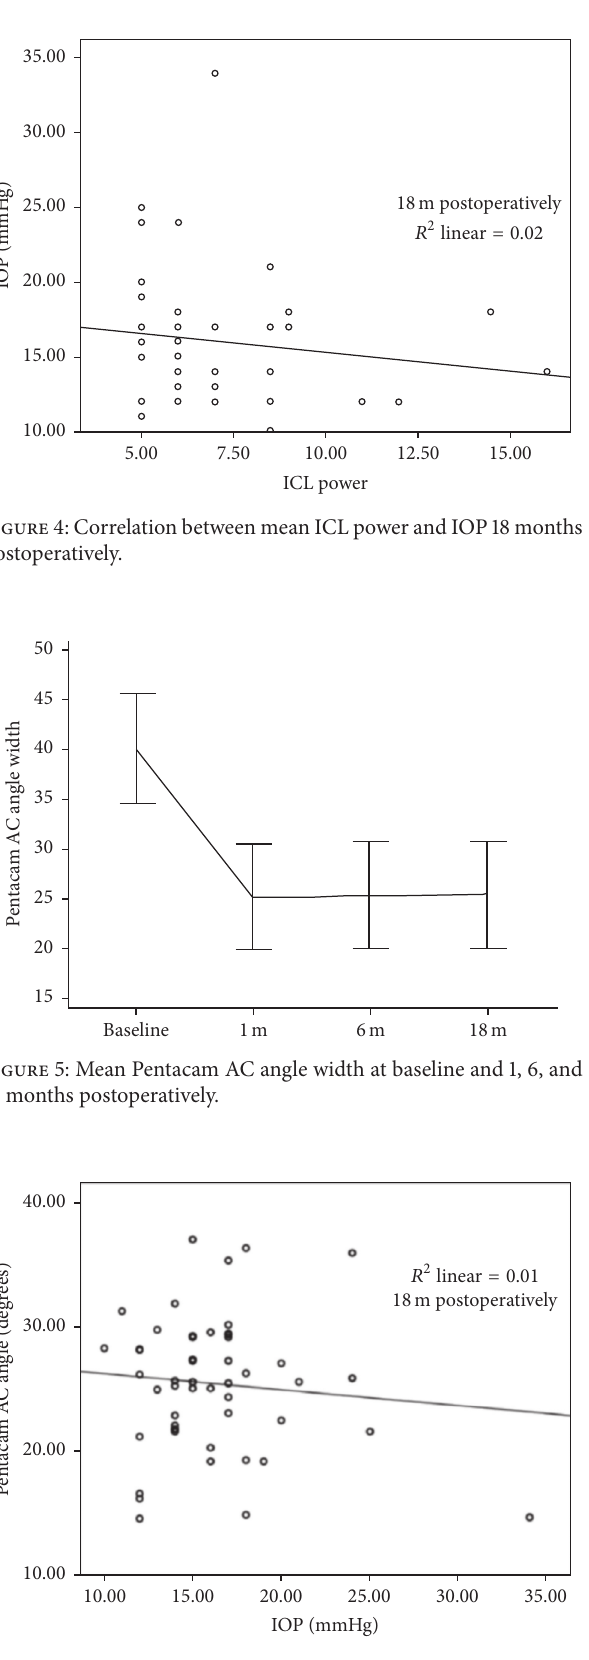
Figure 6: Correlation between Pentacam AC angle width (in degrees) and IOP (in mmHg) 18 months